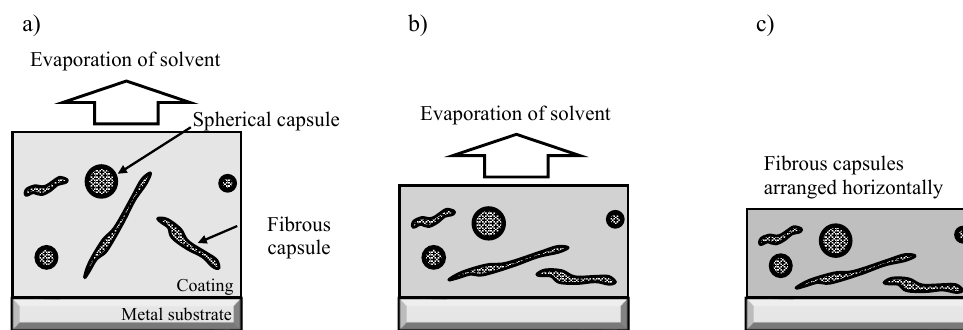
Figure 10. Schematic illustration of the structural changes of the self-healing coating with dispersed spherical capsules (SHC-SC) during aging. ( a ) Just after coating the mixture of prepolymer/ethylene glycol/spherical capsules/cyclohexanone. ( b ) While aging, the reaction of the prepolymer with eth- ylene glycol and the evaporation of cyclohexanone. ( c ) In the last stage of aging, polyurethane and fi lm thinning formed, which led to an increase in capsule density.